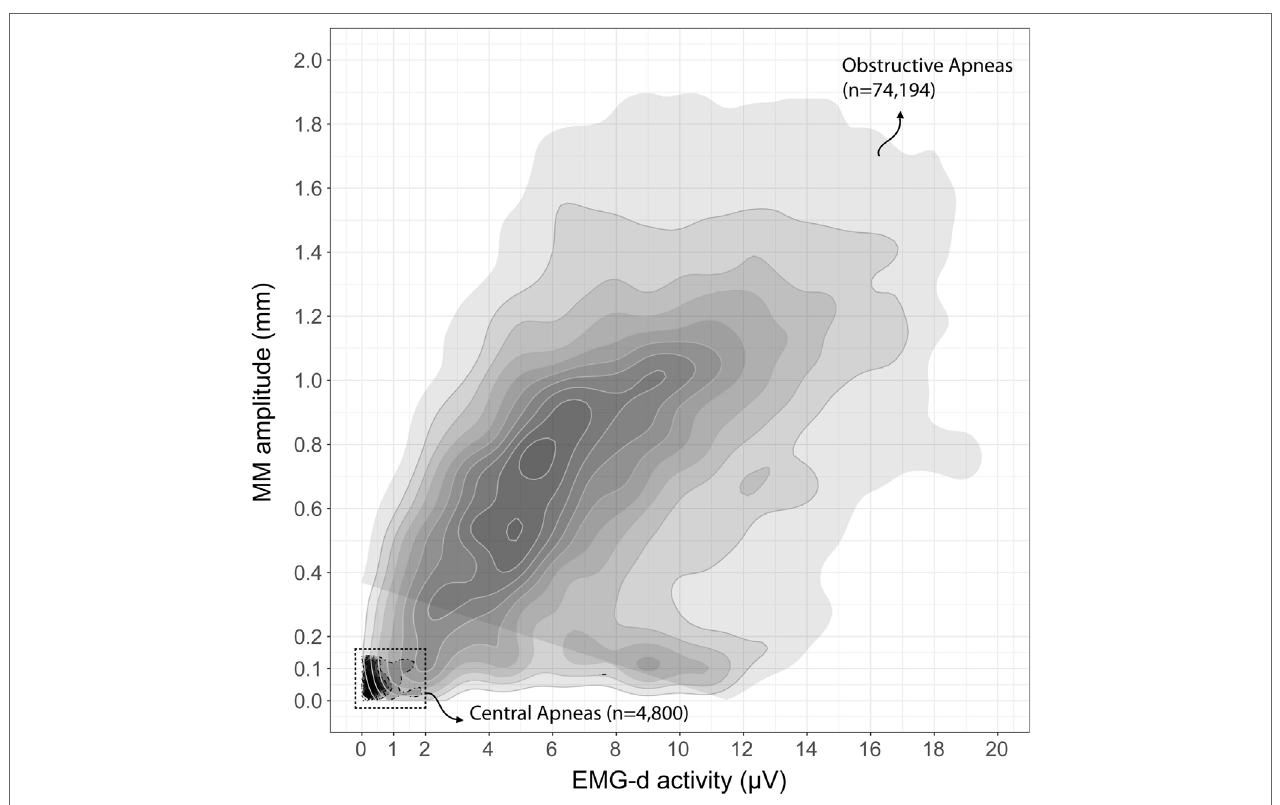
FigUre 3 | Two-dimensional density plot of Mandibular movements (MM) and diaphragmatic electromyography (EMG-d) amplitudes during central and obstructive apneas. Two-dimensional density area was separately determined for central apnea ( n = 4,800, discontinued borderline, black filled area at lower left corner) and obstructive apnea ( n = 74,194, continuous gray borderline). This figure represents the combined information on the association pattern between MM and EMG-d signals and the Gaussian Kernel density of these two variables.